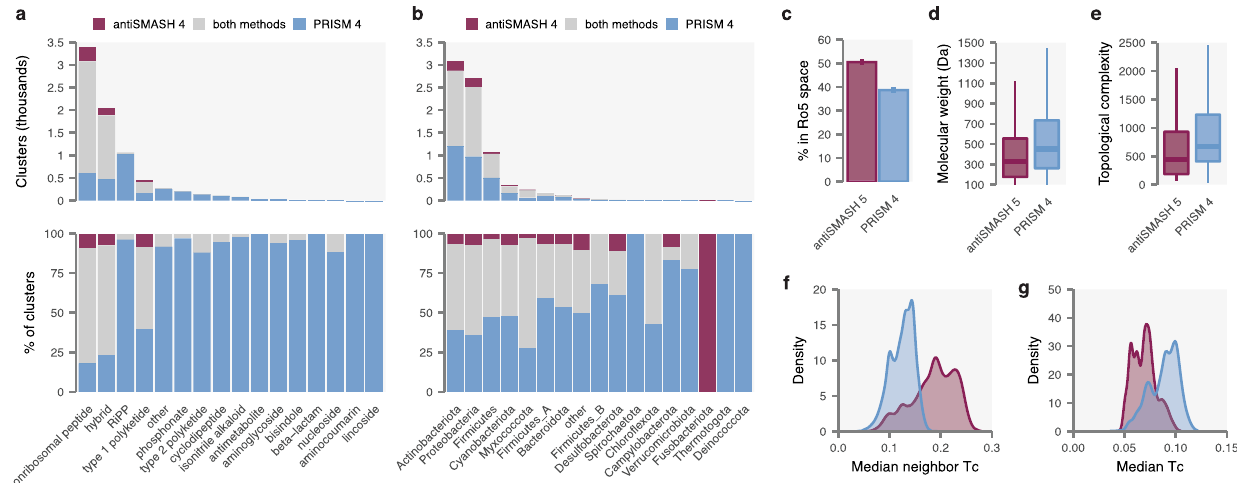
Fig. 3 PRISM 4 reveals secondary metabolite biosynthesis in 3,759 complete bacterial genomes. a , b Number of BGCs with at least one chemical structure predicted by PRISM 4, antiSMASH 5, or both methods in a collection of 3,759 dereplicated complete bacterial genomes, by biosynthetic family ( a ) and phylum of producing organisms ( b ), as classi fi ed in the Genome Taxonomy Database (GTDB) 15 . c – g Structural features of n = 4220 pairs of predicted secondary metabolites from BGCs with products predicted by both PRISM 4 and antiSMASH 5. c Percent of predicted structures in Lipinski rule of fi ve space 20 . Error bars show the standard error of the sample proportion. d Molecular weight of predicted structures. e Bertz topological complexity index 21 of predicted structures. f Internal diversity of predicted structures, as quanti fi ed by median Tanimoto coef fi cient to all other predicted structures in the set. g Similarity of predicted structures to known natural products, as quanti fi ed by the median Tanimoto coef fi cient to the set of known natural products in the Natural Products Atlas. Box plots show median (horizontal line), interquartile range (hinges), and the smallest and largest values no more than 1.5 times the interquartile range (whiskers) throughout. Source data are provided as a Source Data fi